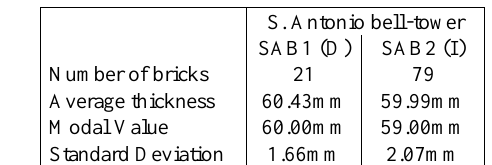
Table 1. Data evaluation from the Oratory bell-tower.